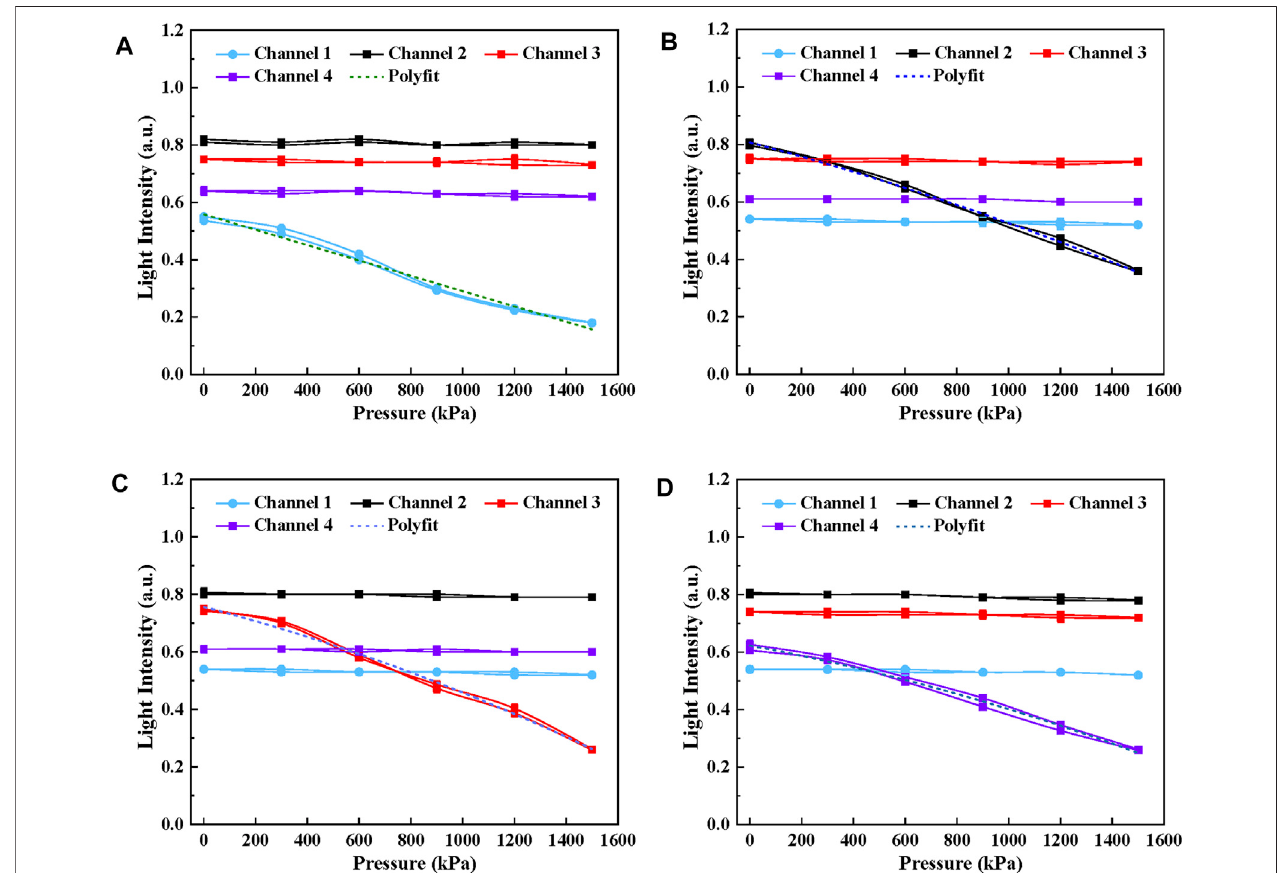
FIGURE 8 | The relationship between output light intensity and the pressure ranging from 0 to 1,500 kPa. (A) Channel 1, (B) Channel 2, (C) Channel 3, (D) Channel 4.